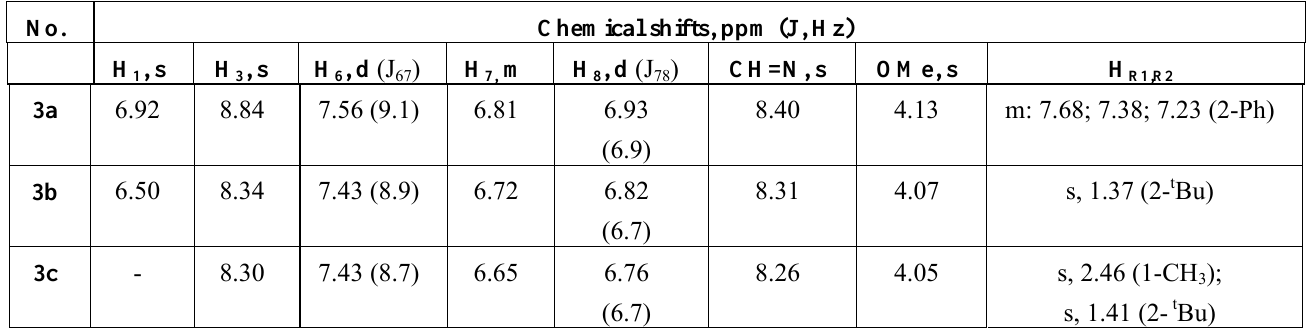
Table 4. 1 H-NMR spectra of O-Me oximes of